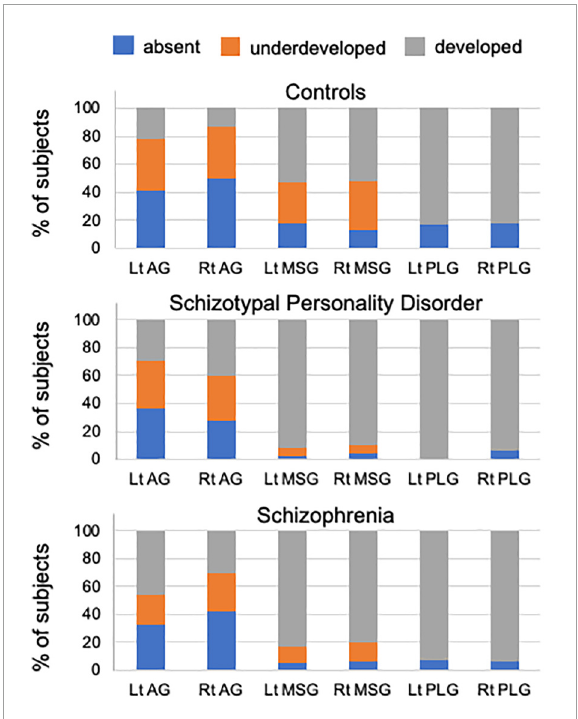
FIGURE2 Percentage of insular gyral development in healthy controls, schizotypal patients, and schizophrenia patients. AG, accessory gyrus; MSG, middle short gyrus; PLG, posterior long gyrus.